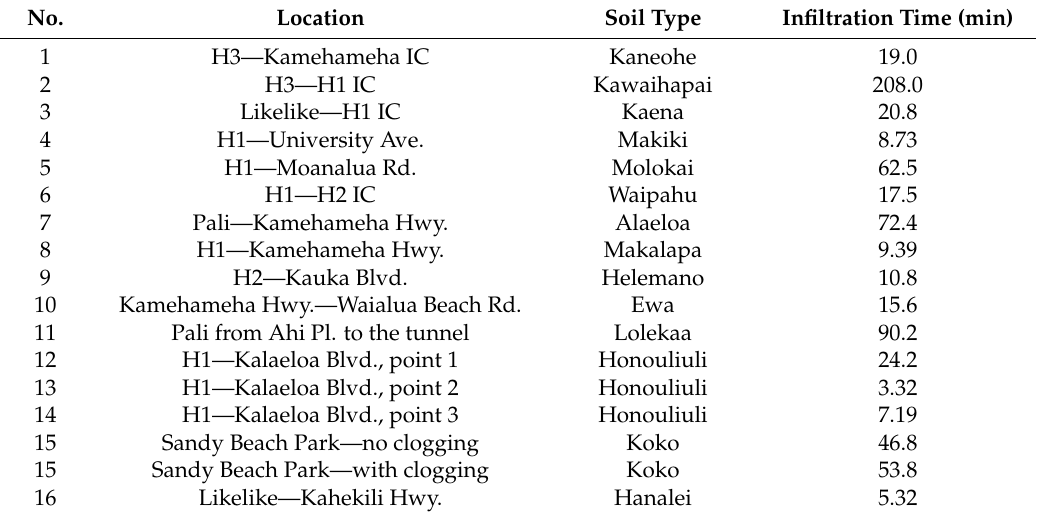
Table 5. Simulated times required for infiltration of 2 L of stormwater in model